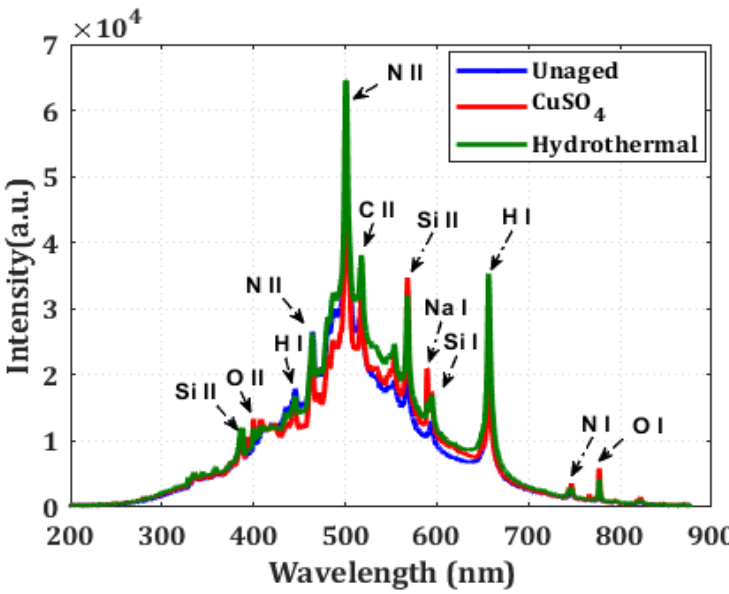
Figure 10. Emission spectra of XLPE sample in the wavelength 200–800 nm.